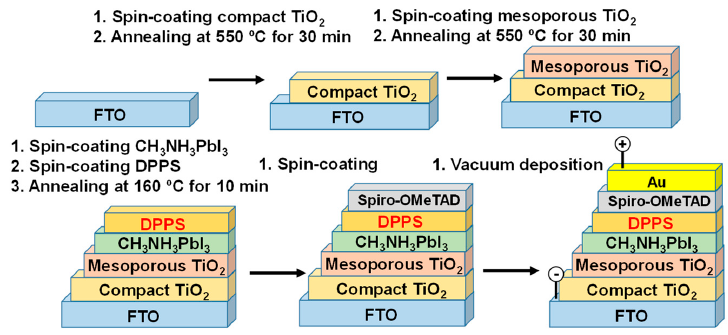
Figure 1. Schematic illustration of the fabrication process of the proposed photovoltaic devices.